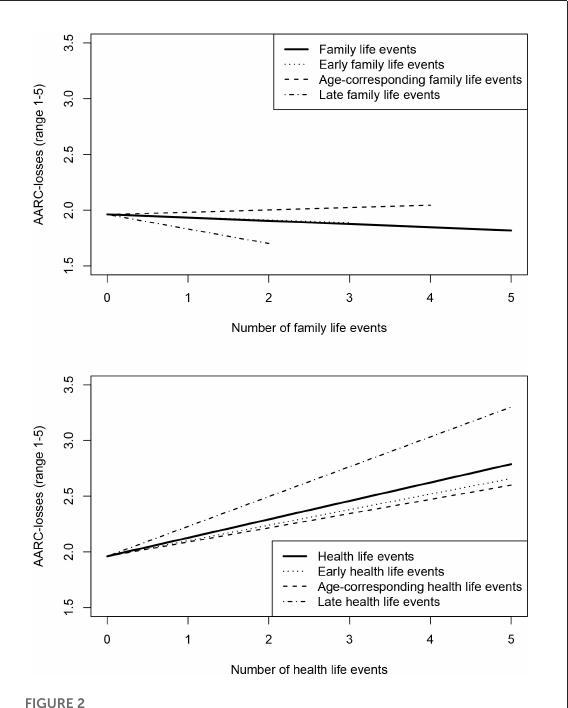
FIGURE2 Number of life events and awareness of age-related losses. Regression lines cover the maximum number of life events occurring in the